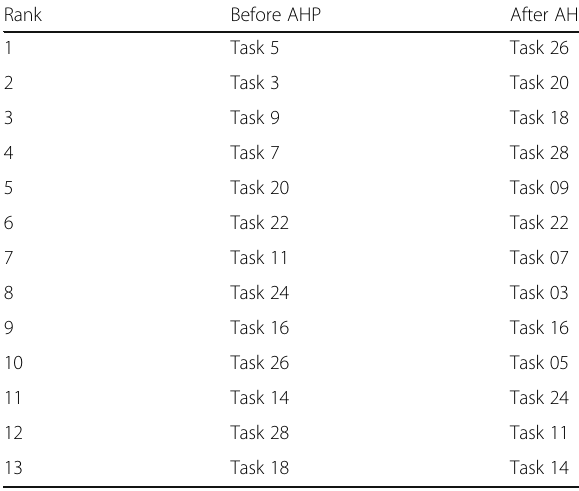
Table 9 AHP rankings of cybershake seismogram synthesis tasks Rank Before AHP After AHP 1 Task